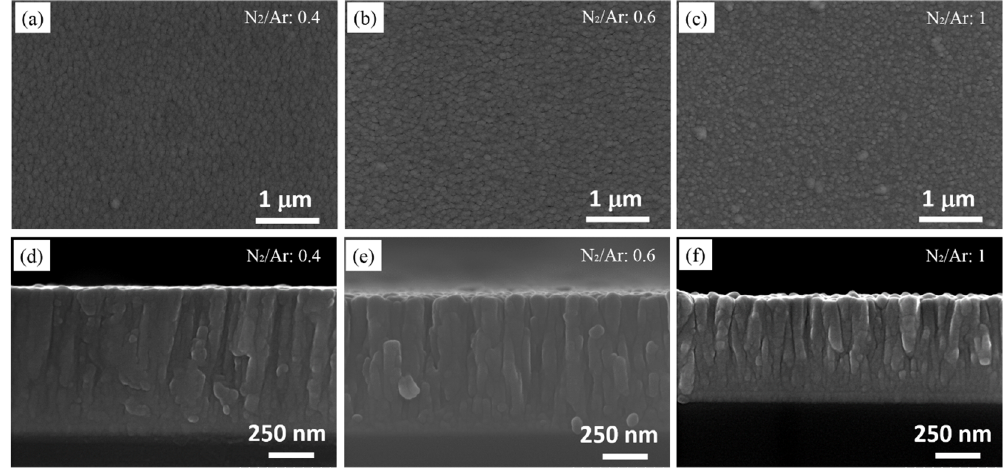
Figure 4. Surface ( a – c ) and cross-sectional images ( d – f ) of NbN x >1 coatings deposited at different N 2 /Ar gas ratios with constant − 50 V bias